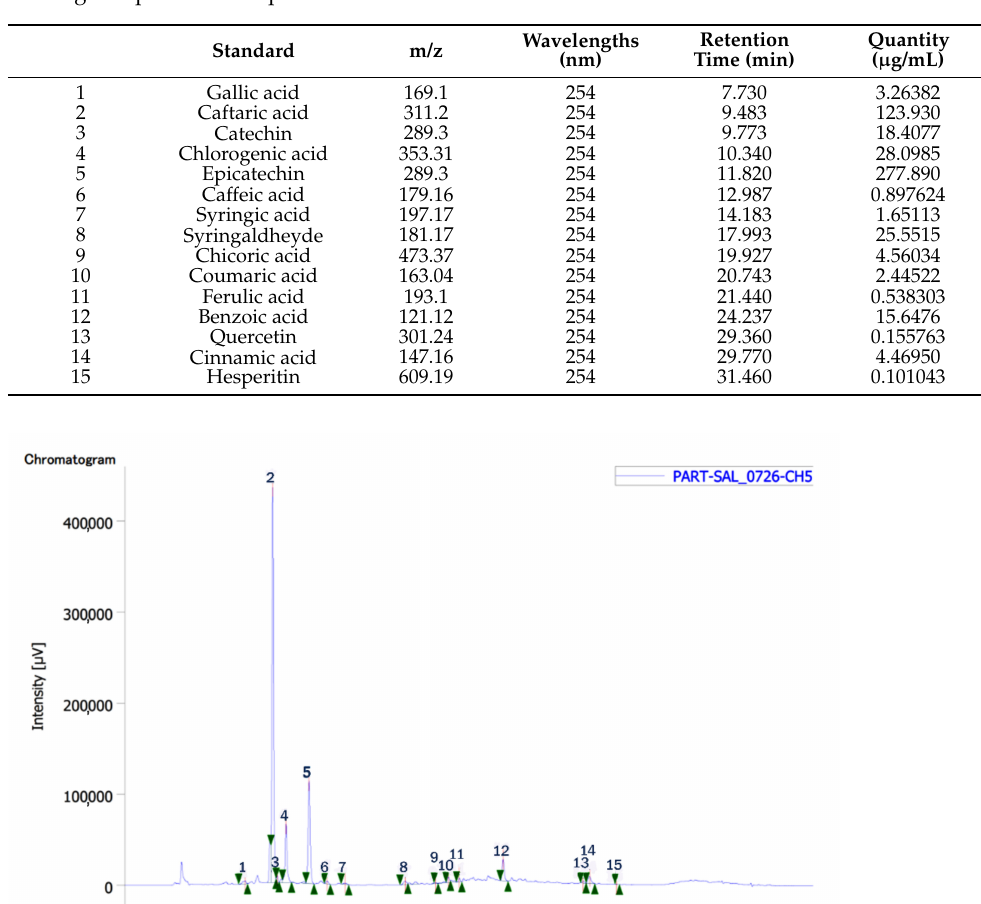
Figure 2. Qualitative mass spectrometry (MS) analysis conducted on the extract mixture. The MS anal- ysis was conducted in negative ion mode (m/z scan mode: 100–1200), and the m/z ratio of 285.1 was monitored to identify the salicin. The present m/z ratio was selected on MassBankEurope database. Table 1. Wavelengths of quantification, mass to charge (m/z) ratios and retention times related to the investigated phenolic compounds.